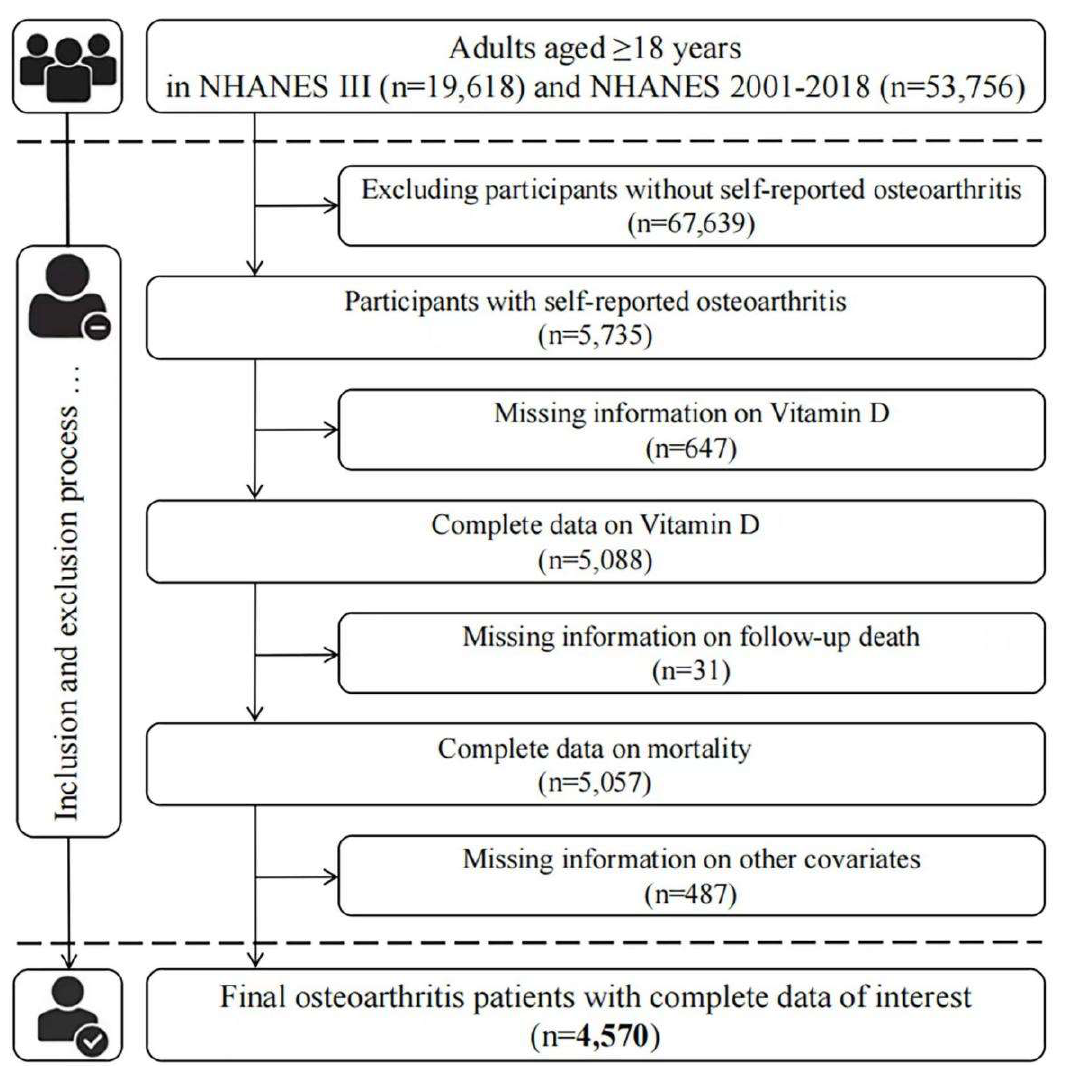
Figure 1. Flow chart of patient inclusion.